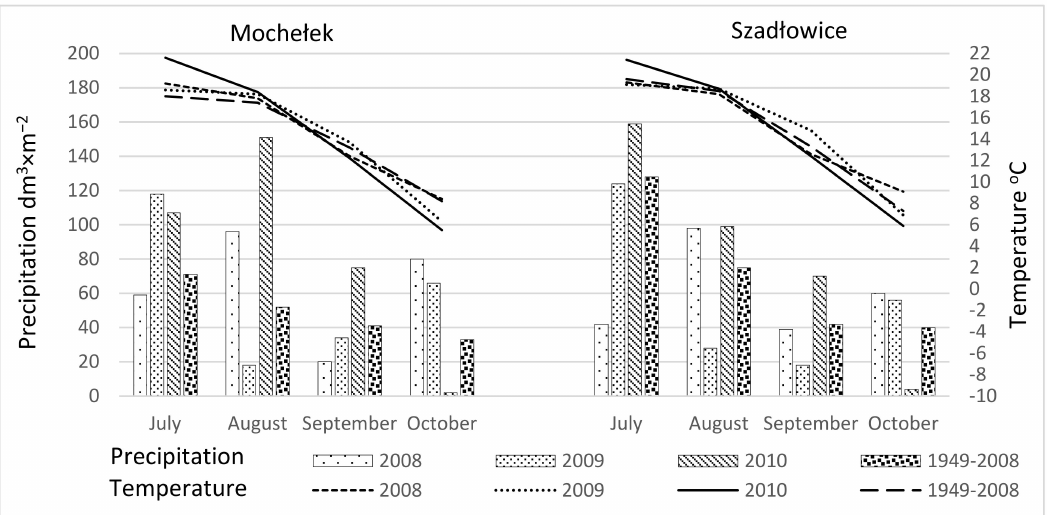
Figure 2. Precipitation and air temperature (2008 to 2010) during catch crop